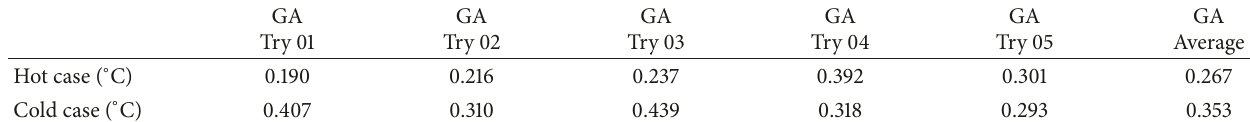
Table 4: Error values achieved with the GA for steady-state cases ( ∘ C).